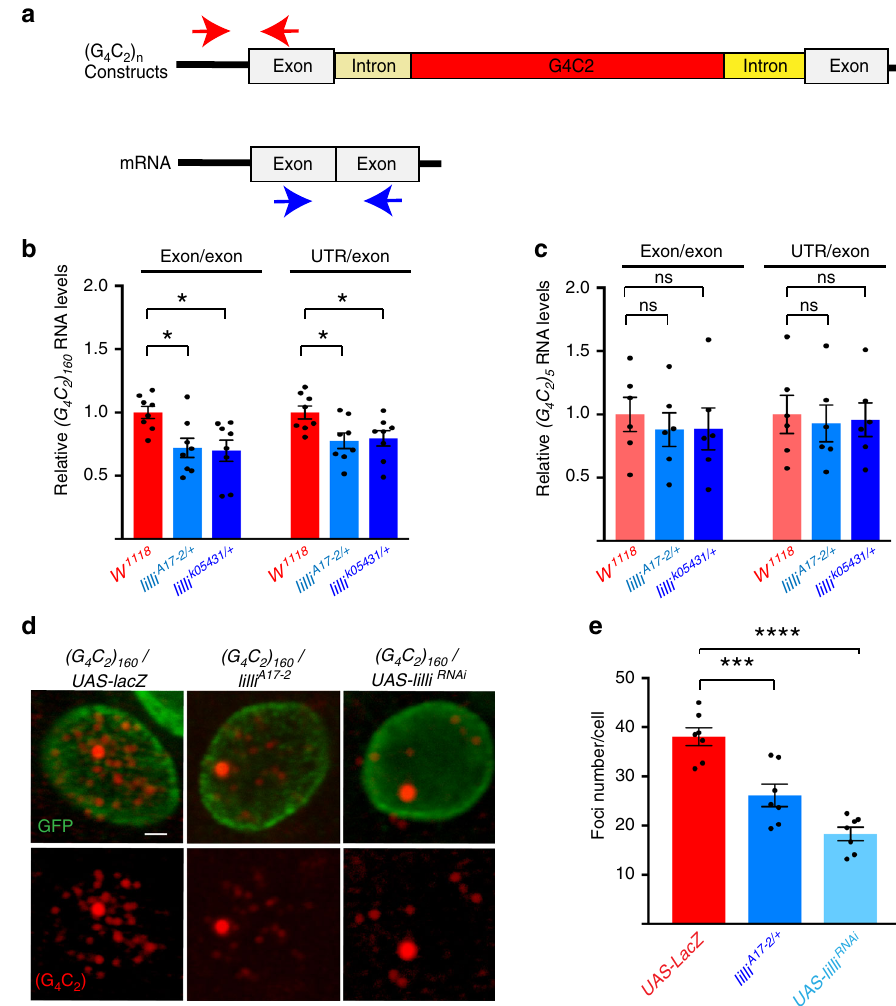
Fig. 5 Lilli regulates expression of expanded G 4 C 2 repeat RNA. a Schematic of the intronic G 4 C 2 repeat model and locations of the primers used for qPCR (red and blue arrows). b qPCR analysis of (G 4 C 2 ) 160 repeat RNA levels in the Drosophila eye. Values are mean ± s.e.m. * p < 0.05 (one-way ANOVA, Dunnett ’ s test). c qPCR analysis of (G 4 C 2 ) 5 repeat RNA levels in the Drosophila eye. Values are mean ± s.e.m. ns not signi fi cant (one-way ANOVA, Dunnett ’ s test). n = 8 independent crosses in b and n = 6 in c . d Formation of nuclear RNA foci by (G 4 C 2 ) 160 repeat RNA in Drosophila motor neurons. Red, RNA foci; green, nuclear GFP. Scale bar: 0.5 μ m. e Number of RNA foci in motor neurons expressing (G 4 C 2 ) 160 with or without partial loss of Lilli activity. n